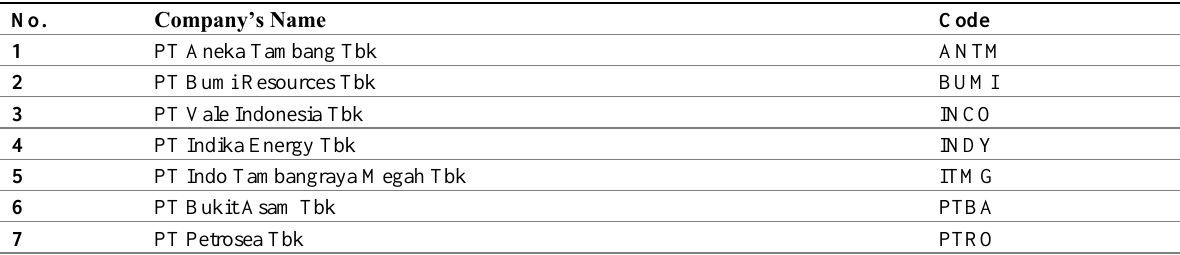
Table 1: List of Research